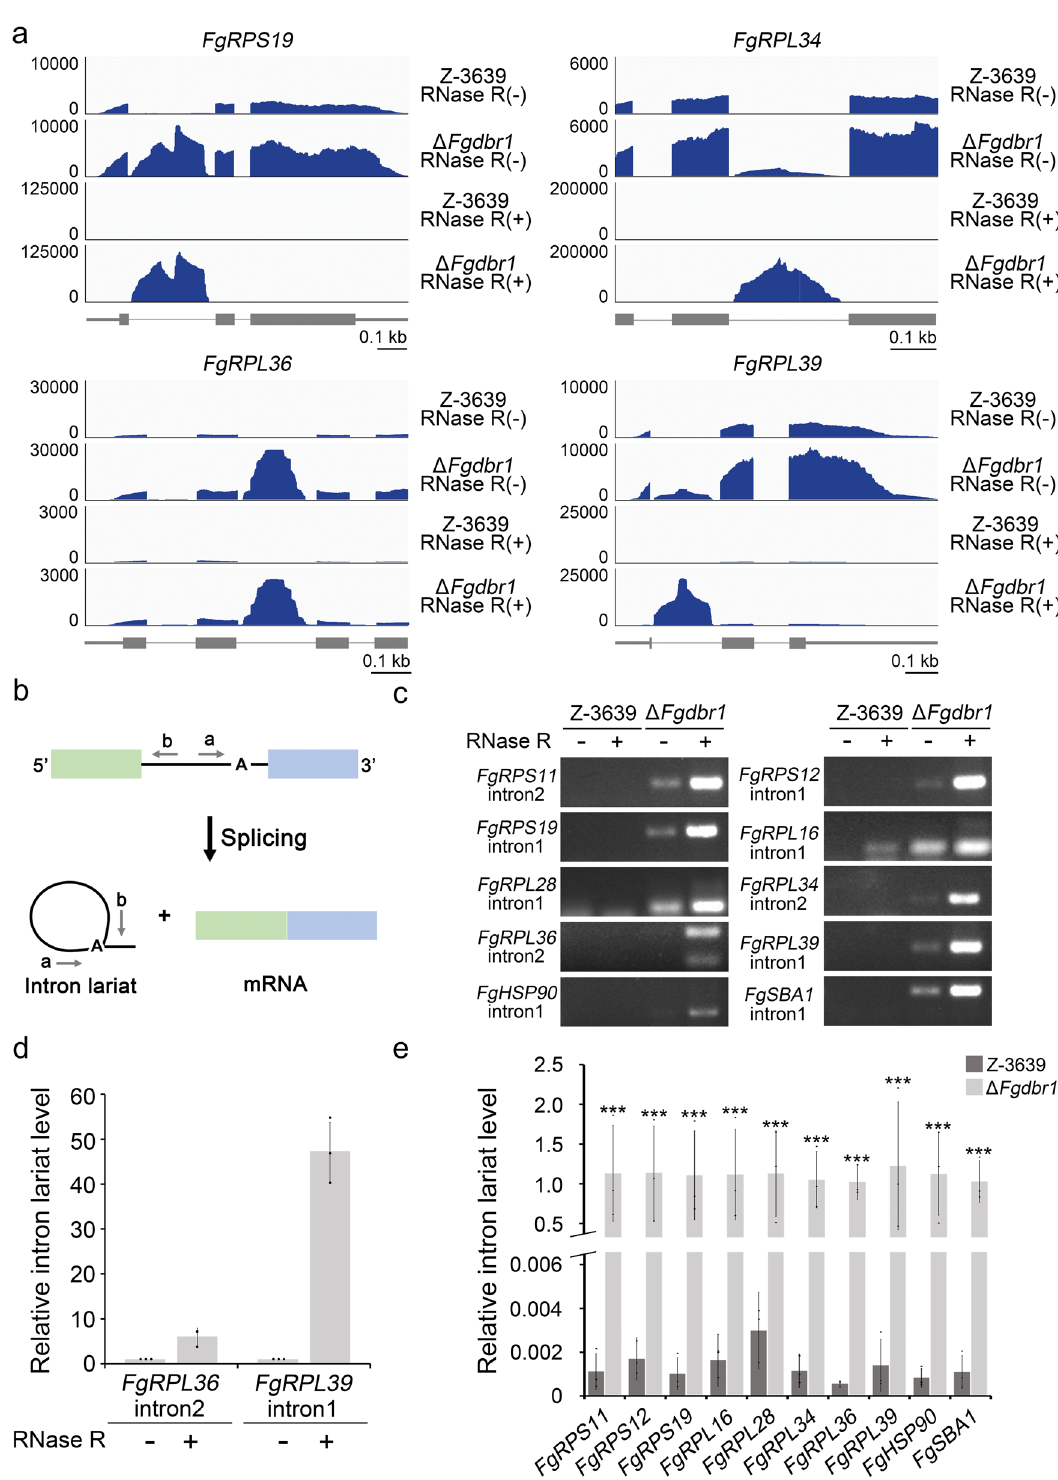
Fig. 7 Identi fi cation of intron lariats in F. graminearum . a Genome browser images of four selected ribosomal protein genes. Aligned RNA-seq data generated from RNase R treated or untreated samples of F. graminearum strains were visualized using IGV. The y -axis represents the TPM. Thick box, coding sequence; thin box, untranslated region; line, intron. b Schematic representation of divergent primers used for amplifying intron lariat RNAs. Green and blue box, exon; line, intron; A, branch point. c Detection of intron lariat RNAs using reverse transcription PCR (RT-PCR) assays. RNA samples of each strain with or without RNase R treatment were ampli fi ed using divergent primers described in a . The images were obtained from 30 cycle of PCR using 2% agarose gels. d Veri fi cation of RNase R treatment. Relative intron lariat levels of Δ Fgdbr1 samples with or without RNase R treatment were determined by qRT-PCR analysis. e Relative intron lariat levels in the wild-type and Δ Fgdbr1 strains. Intron lariat RNA levels of RNase R treated samples were quanti fi ed by qRT-PCR. Error bars represent standard deviations of three biological replicates. *** p < 0.001.